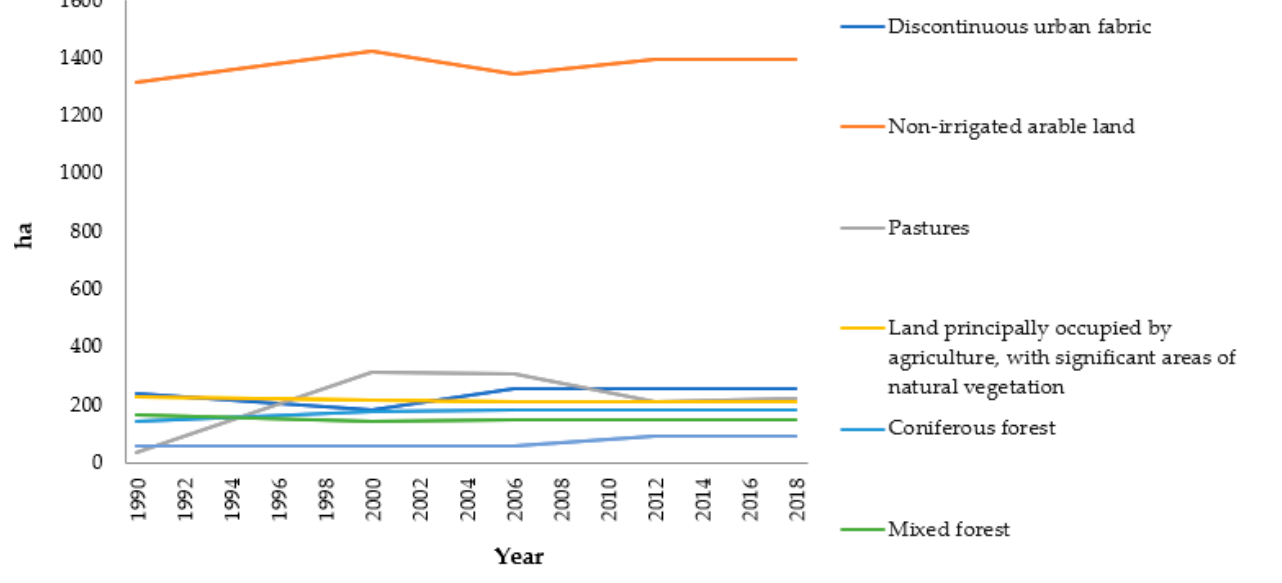
Figure 7. Overview of changes in the individual CLC classes represented in the studied area expressed in ha for each year.